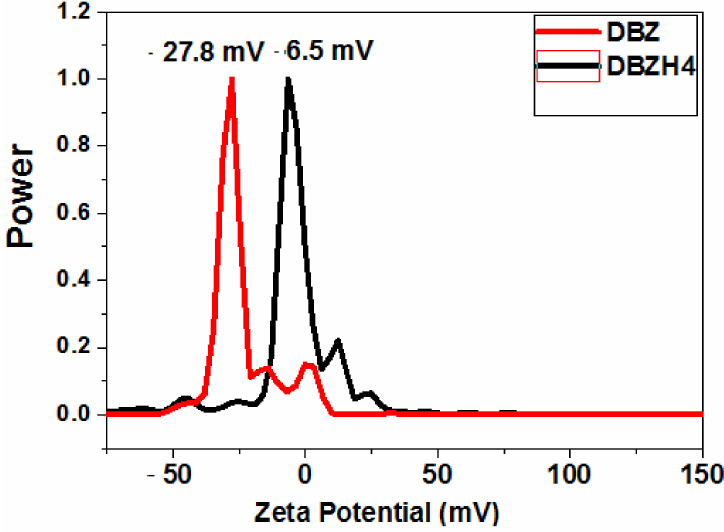
Figure 10. Zeta potentials (mV) of DBZ and DBZH 4